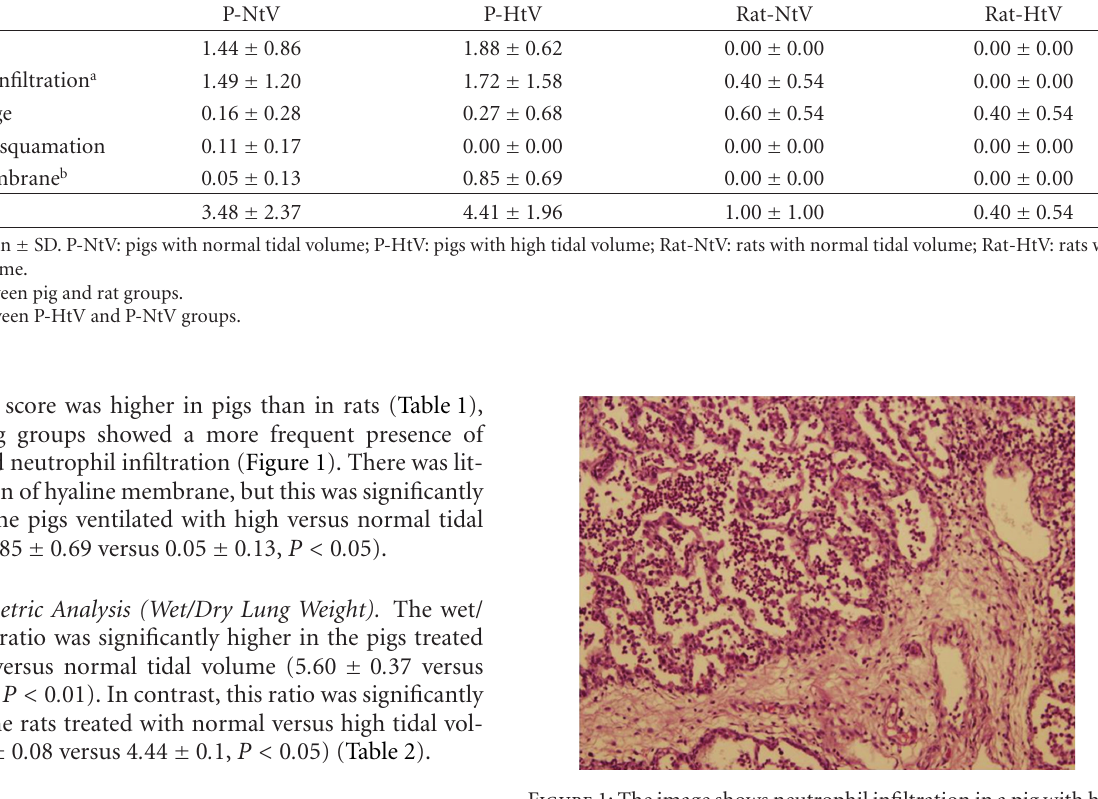
Figure 1: The image shows neutrophil infiltration in a pig with high tidal volume (P-HtV